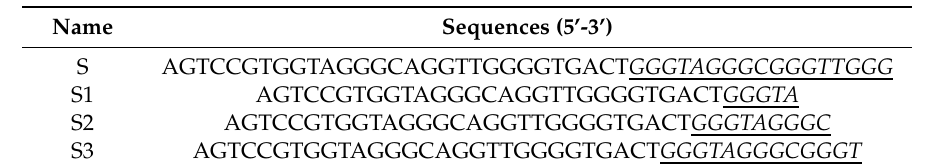
Table 1. Sequences of